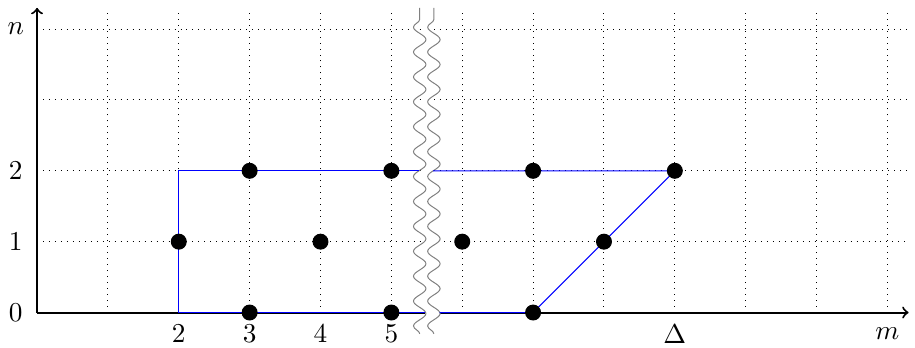
Figure 2. Admissible Lorentz labels of zero-forms for odd ∆